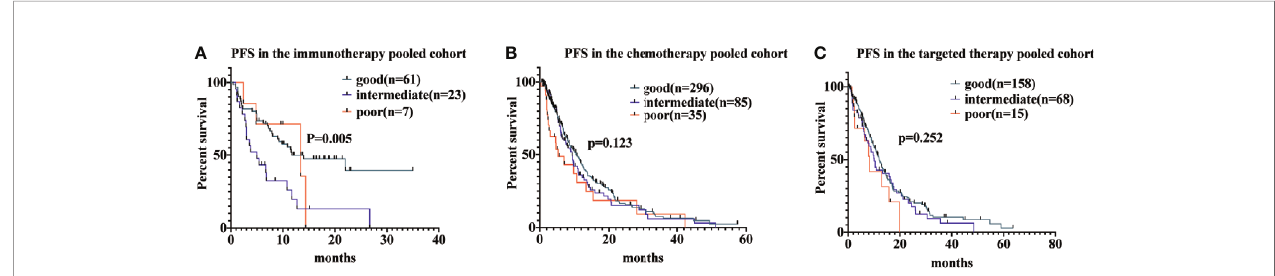
FIGURE 1 | Associations of the lung immune prognostic index (LIPI) score and progression-free survival (PFS) following systemic therapy among non-small cell lung carcinoma (NSCLC) patients. Kaplan-Meier curves of PFS, comparing patients receiving immunotherapy, chemotherapy, and targeted therapy, are presented in (A – C) , respectively.